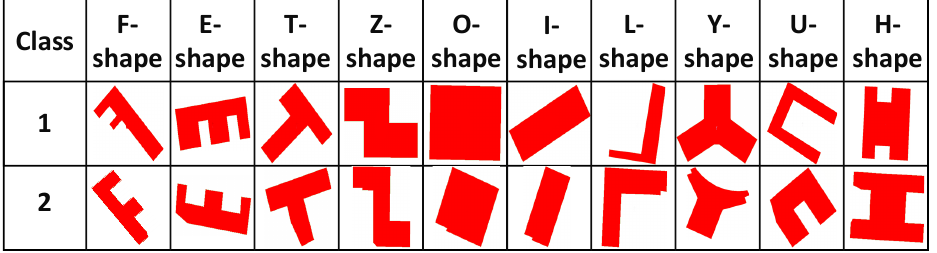
Figure 3. Examples of 10 different types of data in the